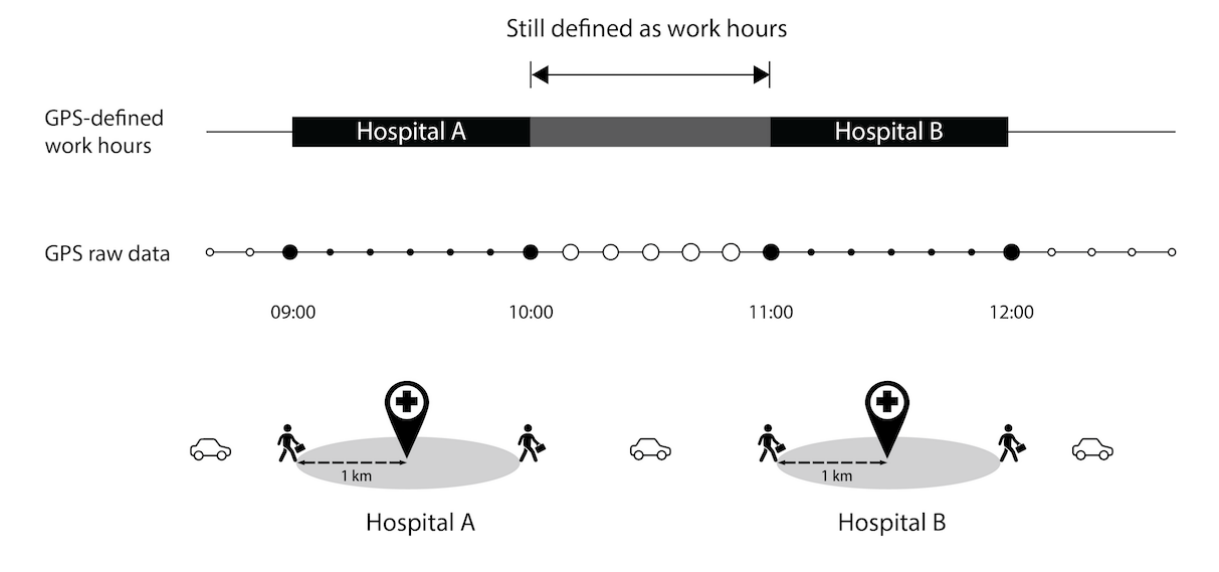
Figure 1. The recording process of GPS-defined work hours. For GPS raw data, the time interval between each dot is 10 min. If the coordinates captured are within the range, the dot is marked as solid; hollow if otherwise.